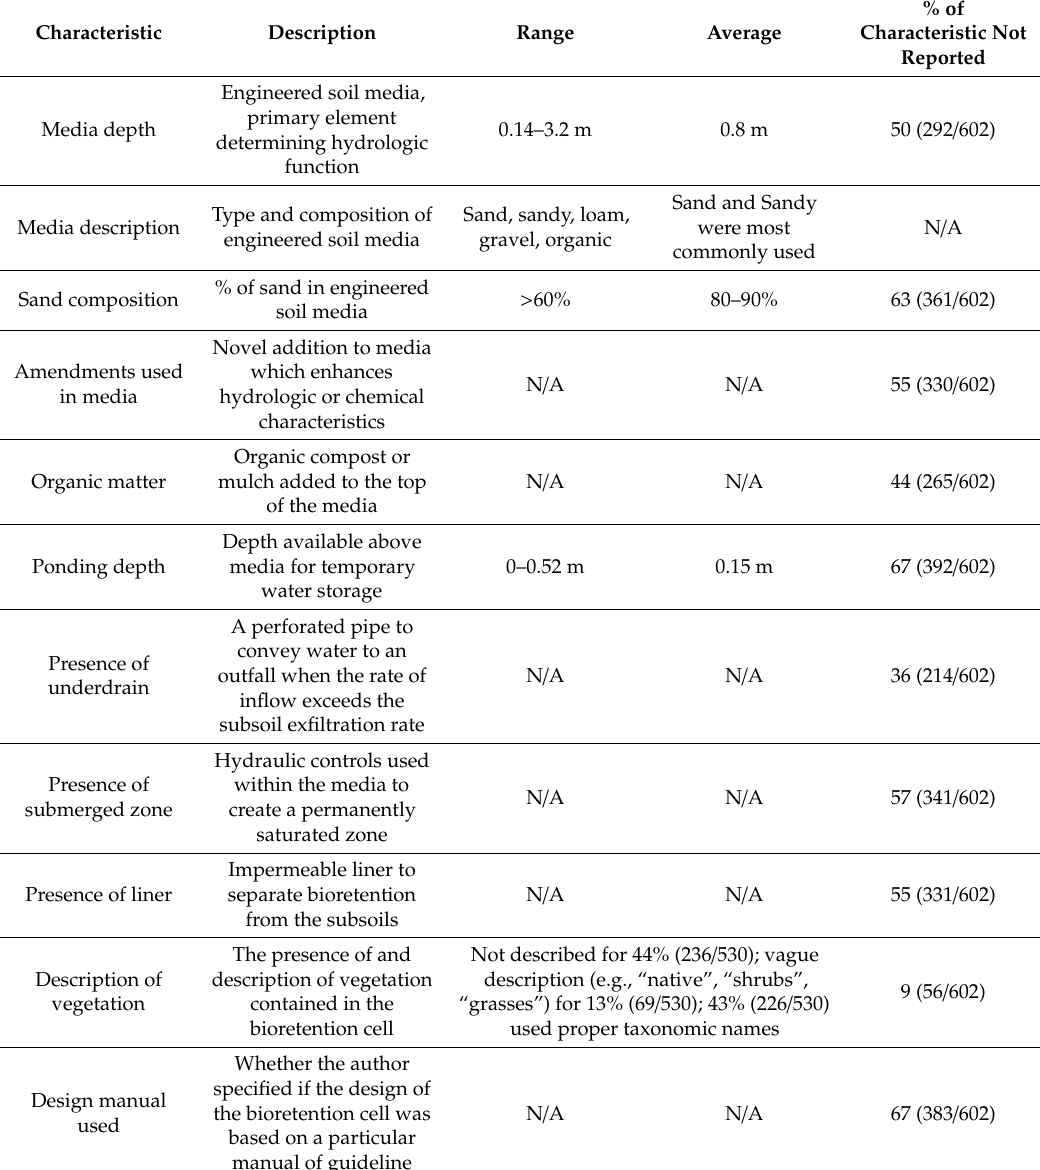
Table 2. Bioretention cell physical characteristics reported by study authors, including description, range, average or more frequently reported, and the frequency of that characteristic being not reported out of 602